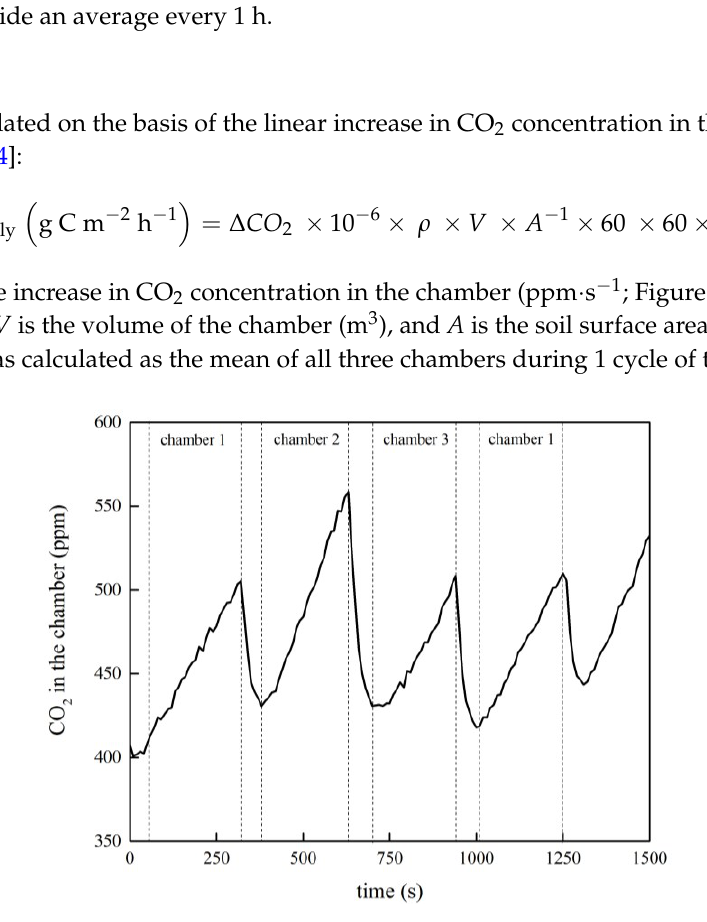
Figure 3. Changes in CO 2 concentration in chambers during the measurements using the AOCC system. ∆ CO 2 was calculated from the intervals, which are evident from the high and low values that intersect the dotted lines.